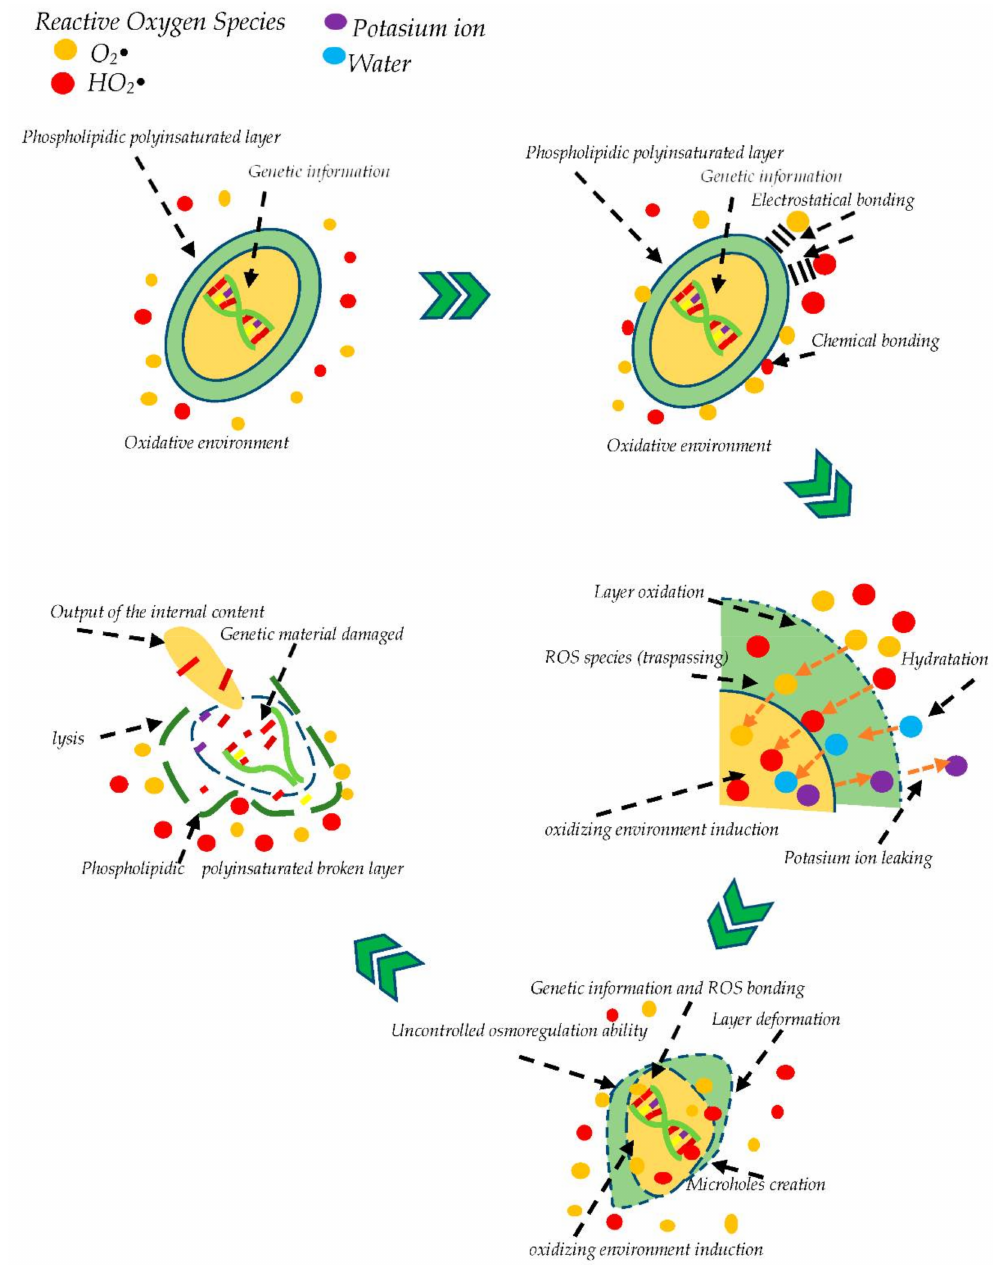
Figure 2. Disinfection mechanism purposed for Bacteria using TiO 2